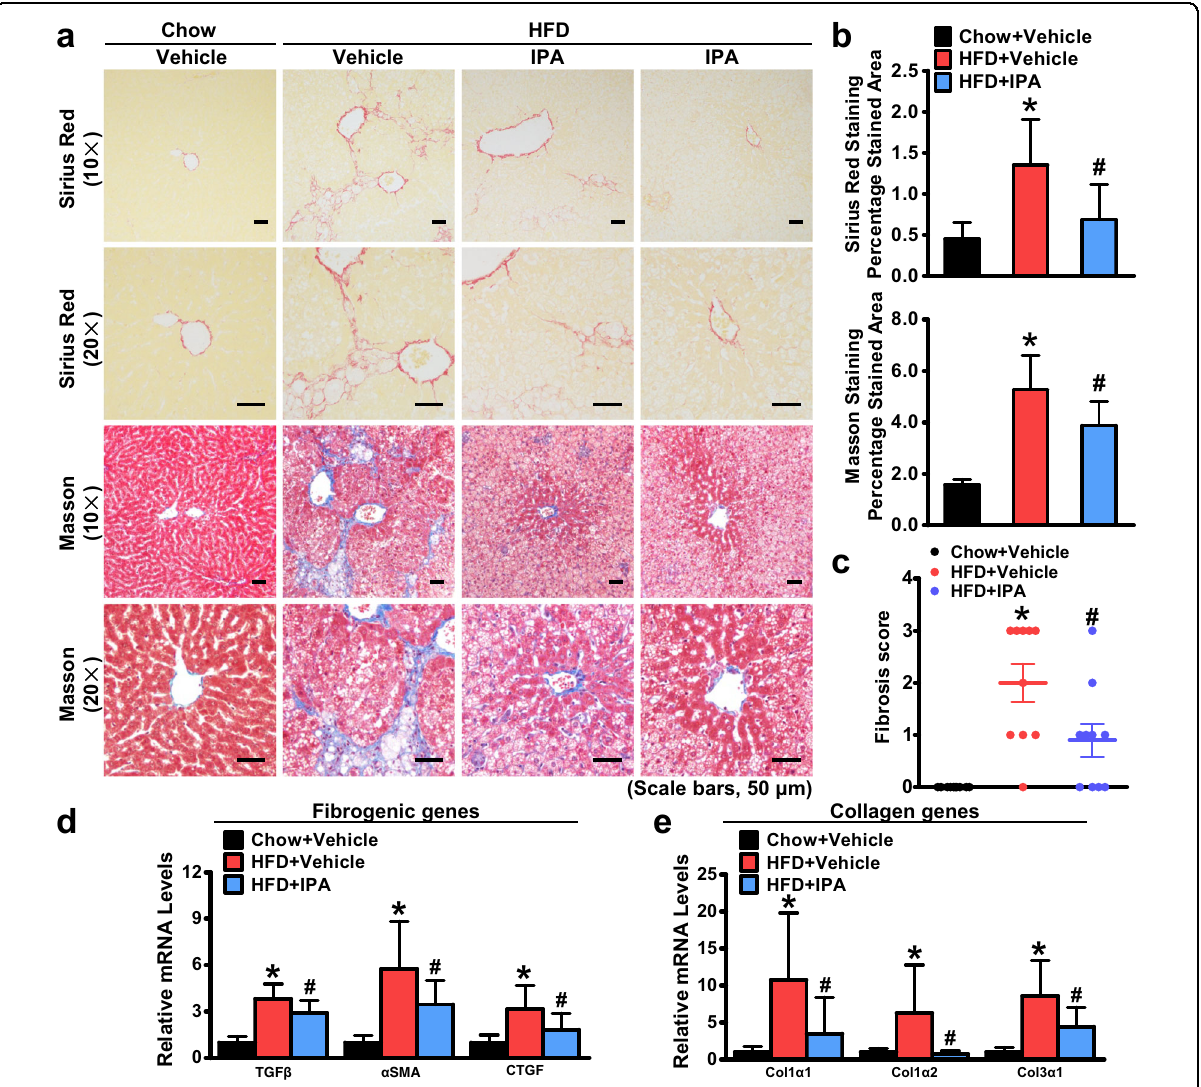
Fig. 6 The expression of genes promoting fi brosis is altered in the livers of rats treated with IPA, leading to a reduction in liver fi brosis. a Representative Sirius Red and Masson trichrome staining of liver sections (scale bars, 50 μ m). b Quanti fi cation of Sirius Red and Masson-stained areas is shown. c Fibrosis was scored based on histological alterations. The expression levels of fi brogenic genes ( d ) and collagen genes ( e ) were determined by real-time PCR. Relative expression levels were normalized to those of GAPDH. The data are presented as the mean ± SEM. n = 7 – 10, * P < 0.05, vs. rats fed a chow diet; # P < 0.05, vs. rats fed a high-fat